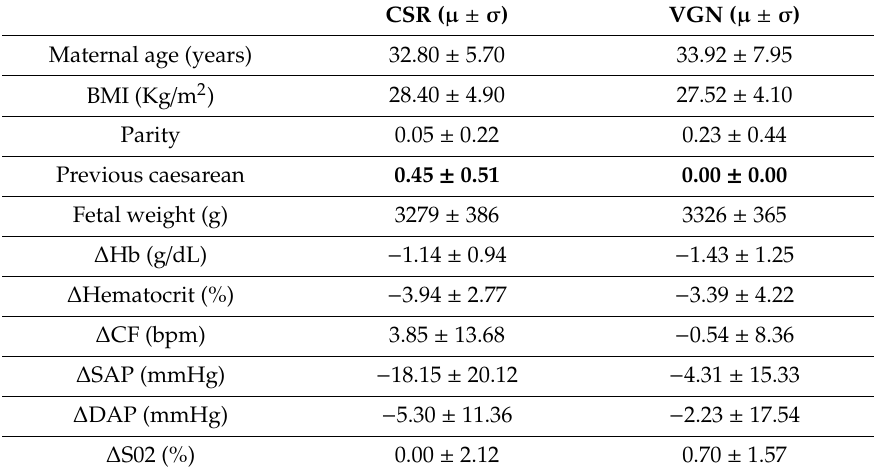
Table 1. Mean and standard deviation values of the obstetric data and vital sign variation before and 24 h after delivery in the study population. Values in bold indicate significant di ff erences between groups ( α = 0.05). CSR: elective caesarean delivery; VGN: vaginal delivery; BMI: Body Mass Index; CF: Cardiac Frequency; SAP: Systolic Arterial Pressure; DAP: Diastolic Arterial Pressure.